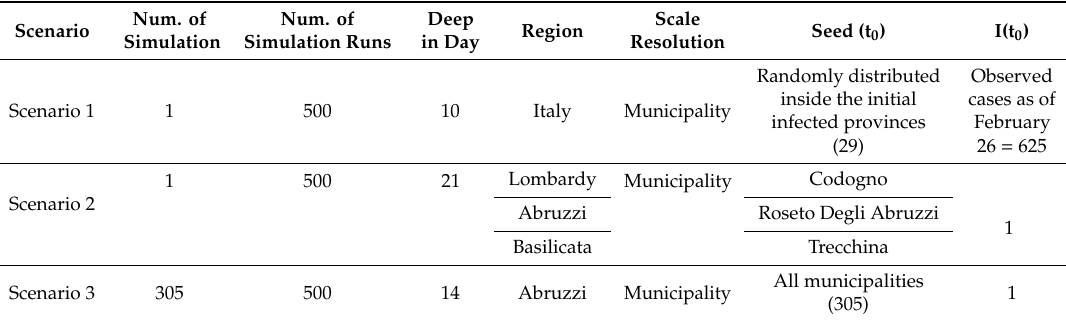
Table 1. Simulation parameters for each scenario.